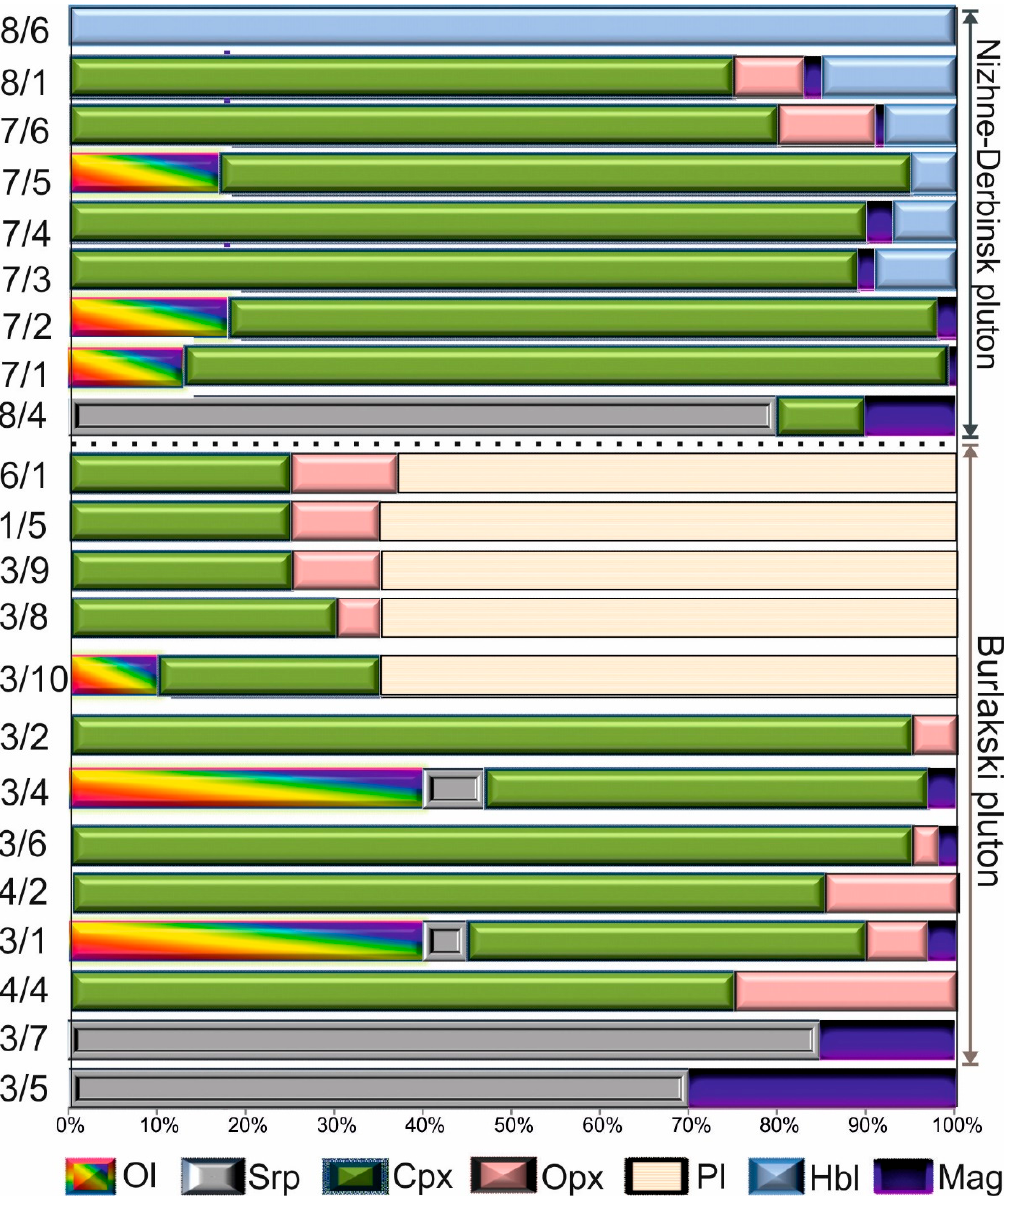
Figure 4. Mineralogy (vol. %) of the collected samples from the Burlakski and Nizhne-Derbinsk plutons represented a rough guide of stratigraphic height of these samples in the both plutons. Samples in each pluton shown in ascending order. Ol, olivine; Srp, serpentine; Cpx, clinopyroxene; Opx, orthopyroxene; Pl, plagioclase; Hbl, hornblende; Mag, magnetite